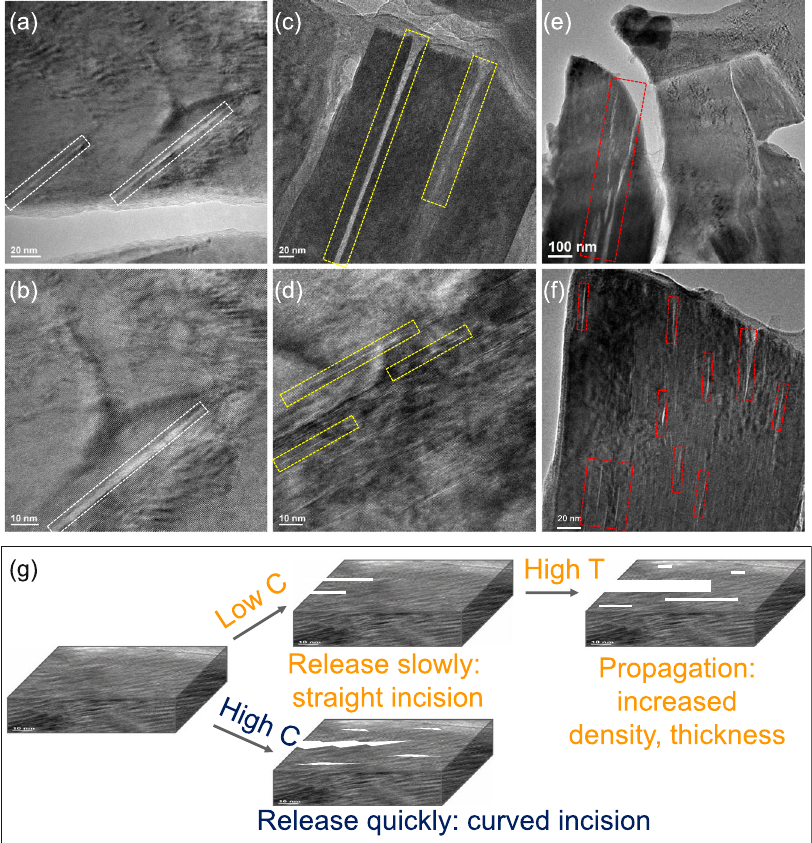
Fig. 7 Strain relaxation under different conditions. Low and high magni fi cation TEM images of O3 NaNi 0.4 Mn 0.4 Co 0.2 O 2 cathode after 100 cycles within 2.0 – 4.4 V at different conditions: a , b 0.08C under room temperature; c , d 0.2C under 55 °C, and e , f 1C under room temperature. g Schematic illustration on the morphologies of nanogaps in the cycled O3 NaNi 0.4 Mn 0.4 Co 0.2 O 2 as a function of cycling